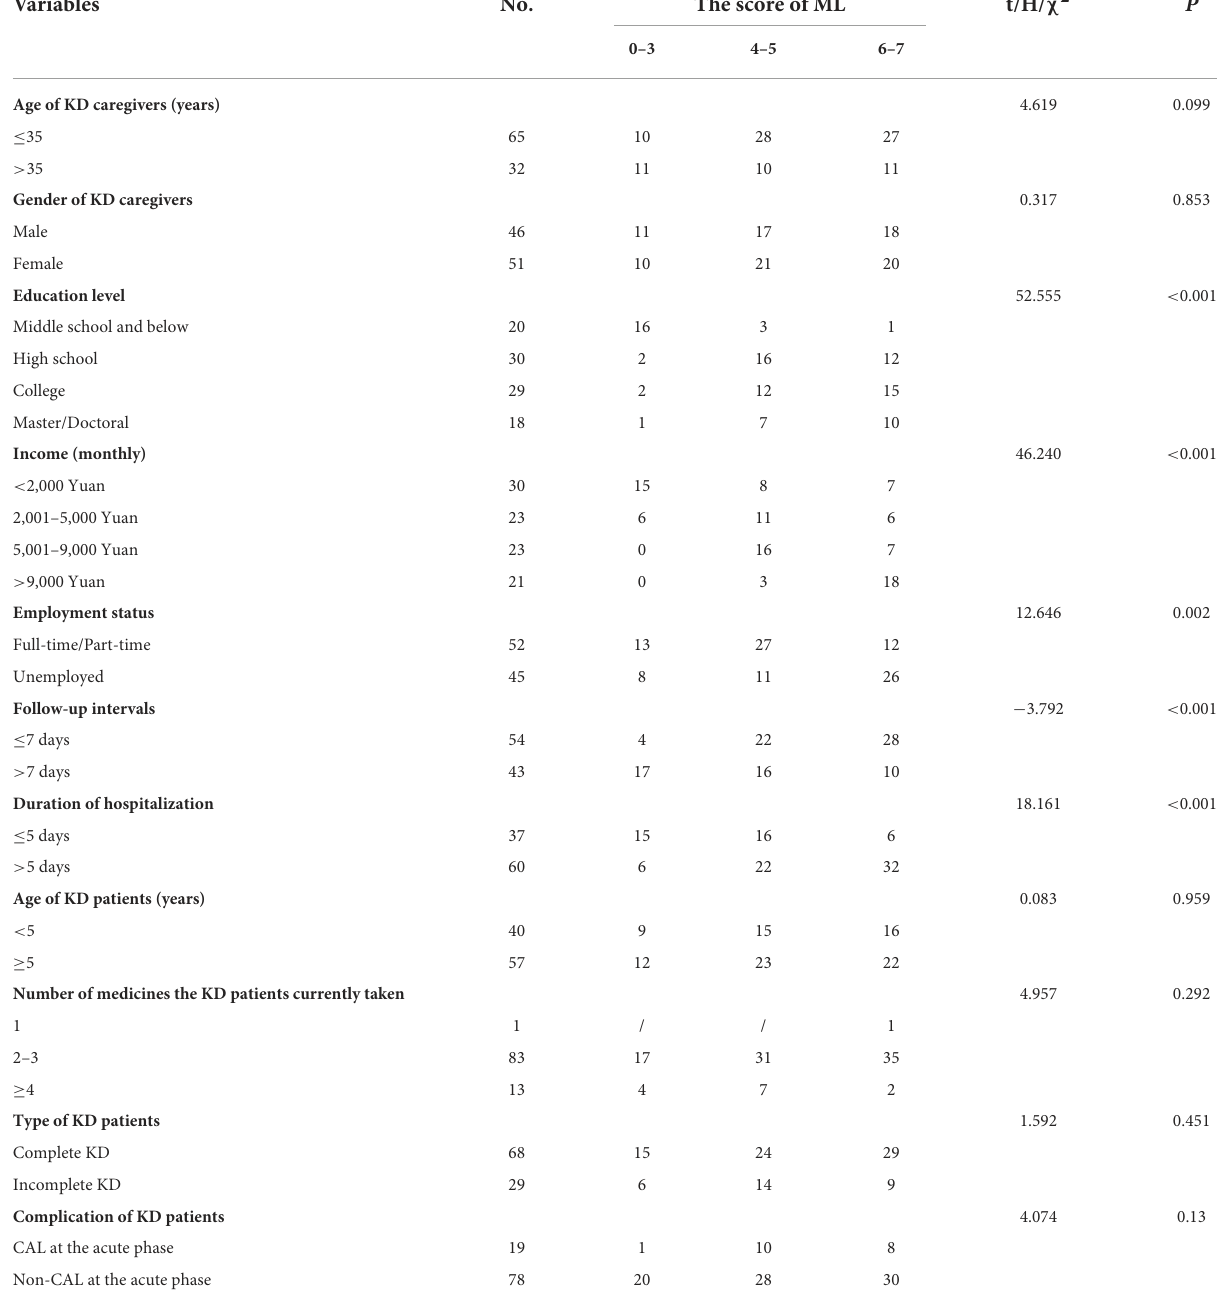
TABLE 3 Univariate analysis of determinants of medication literacy for KD caregivers.